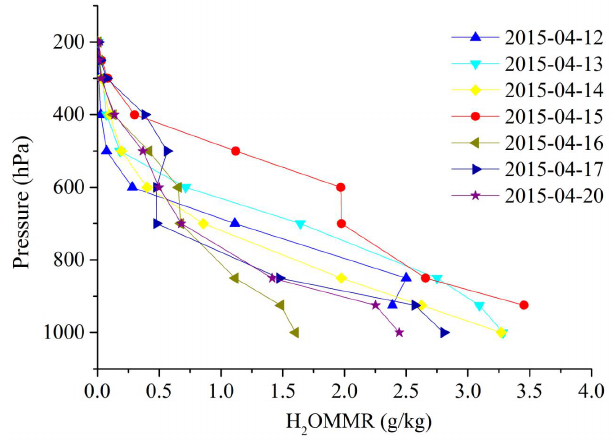
Figure 13. H 2 O mass mixing ratio during dusty and non-dusty days. The red line represents profile during the dusty